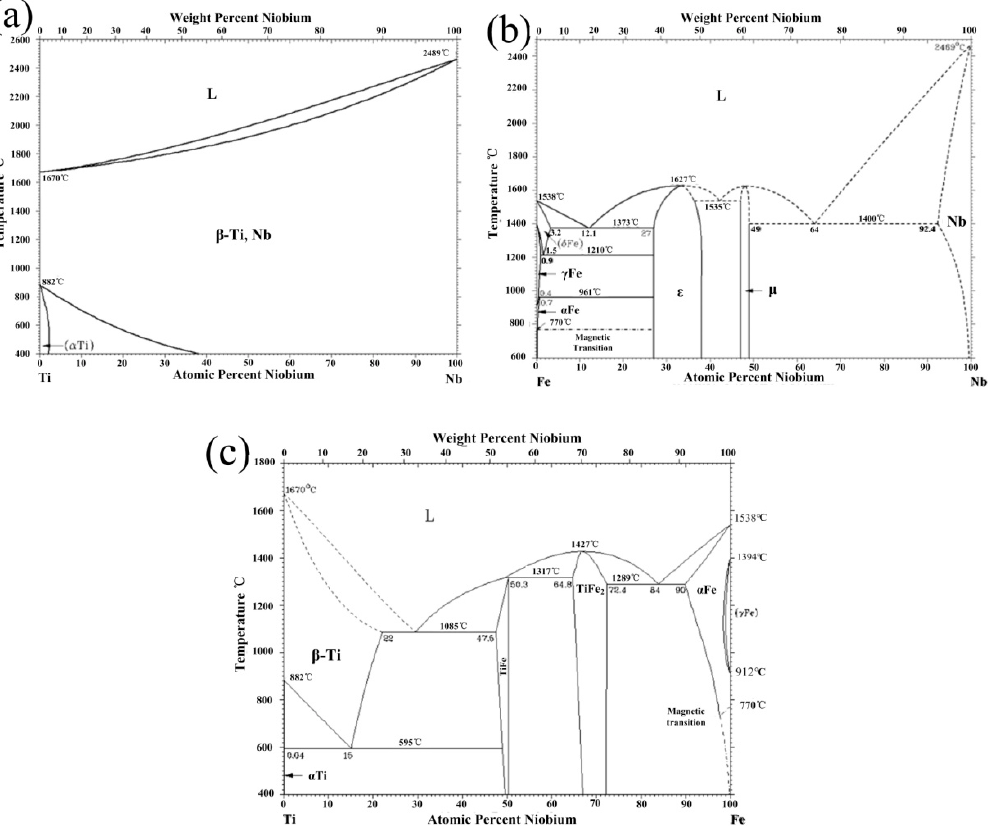
Figure 3. The binary phase diagrams of different elements: ( a ) Ti-Nb; ( b ) Fe-Nb and ( c ) Ti-Fe. The WDS line scanning results of Fe, C, Nb and Ti across the Ti/Nb and Nb/steel clad interface